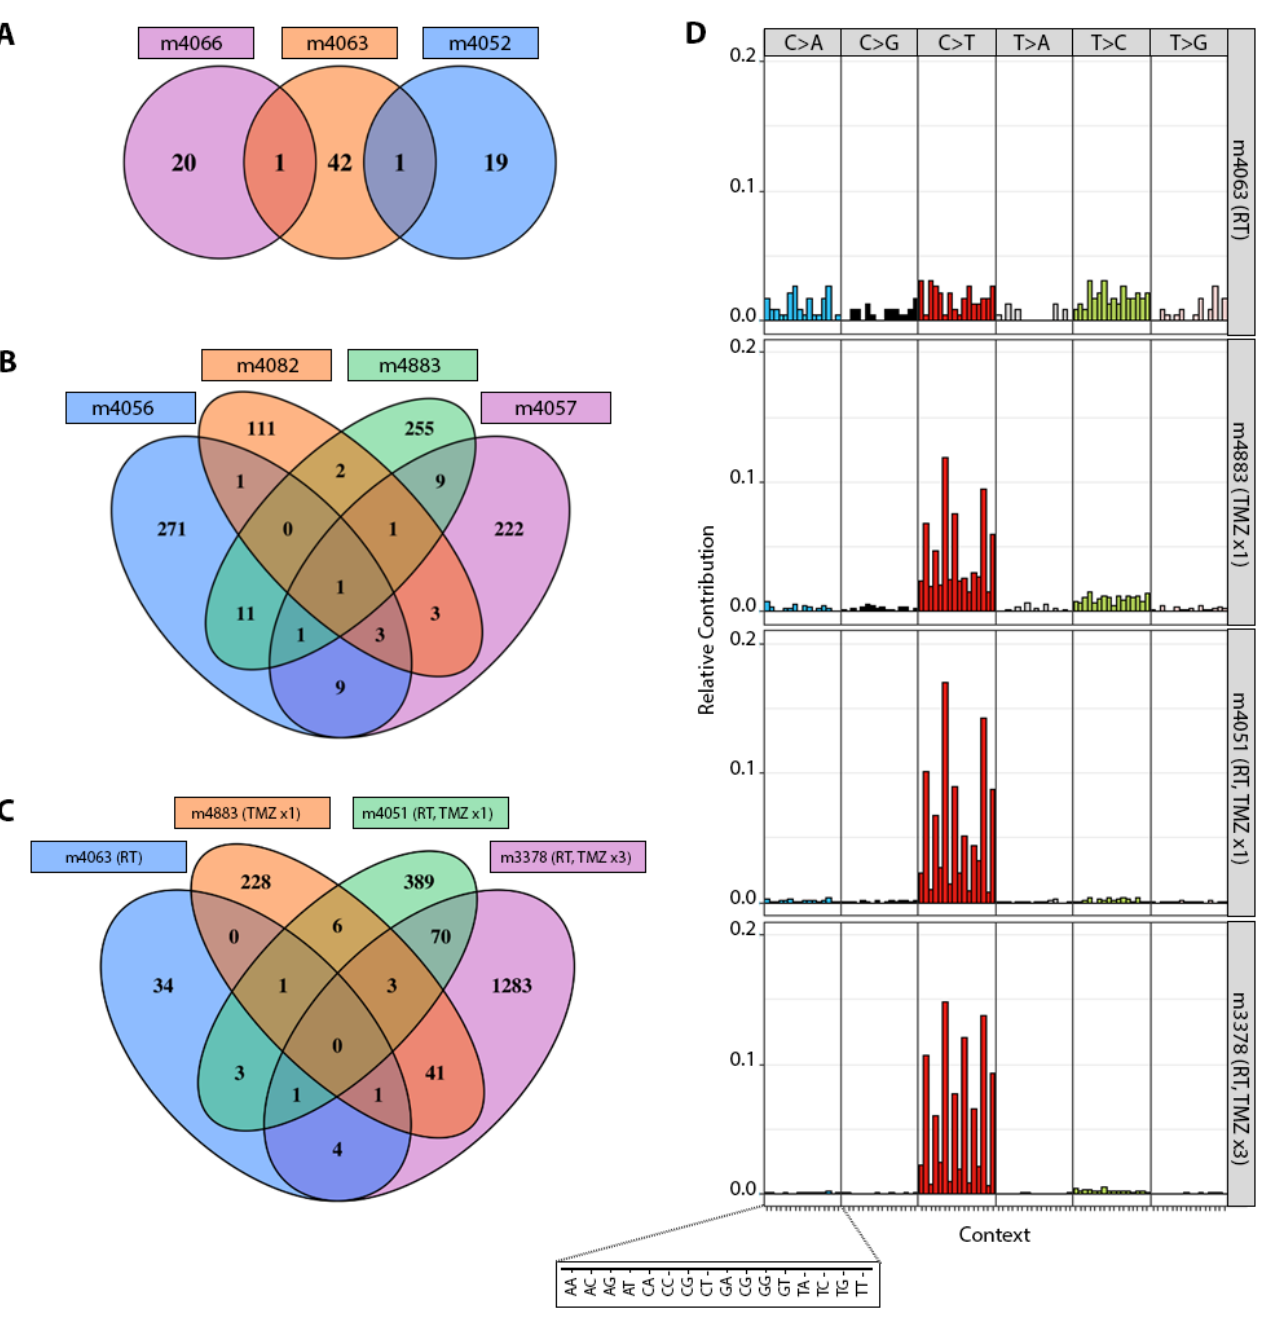
Figure 2. Mutations in GBM6 derivative PDX. ( A ) Venn diagram illustrating numbers of mutated genes in PDX derivatives treated with radiation therapy (m4066, m4063, m4052). ( B ) Numbers of mutated genes in PDX derivatives treated with a single cycle of TMZ (m4056, m4082, m4883, m4057). ( C ) Comparison of numbers of mutated genes in PDX derivatives treated with indicated combinations of RT and TMZ. ( D ) Illustration and comparison of the relative frequency of mutations affecting C and T sites in select GBM6 derivatives treated with the indicated combinations of RT and TMZ.